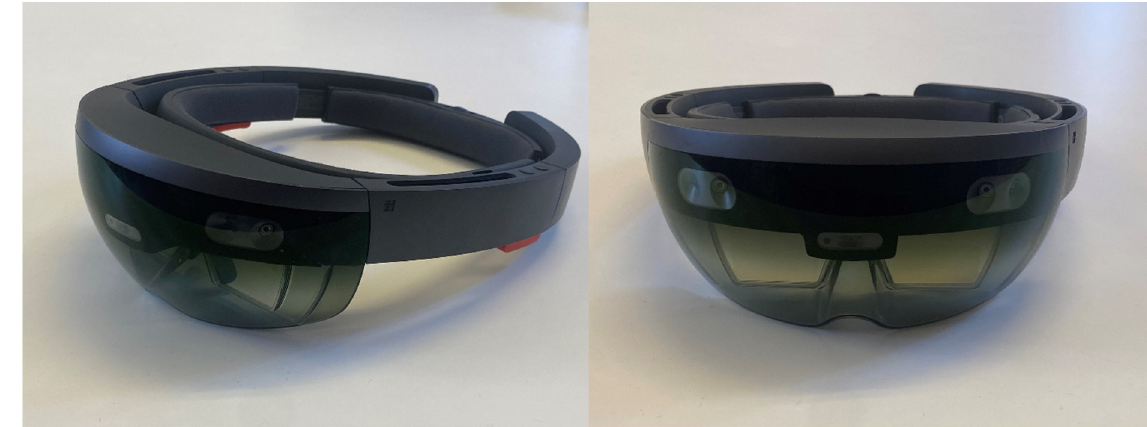
Figure 6. MS HoloLens MR